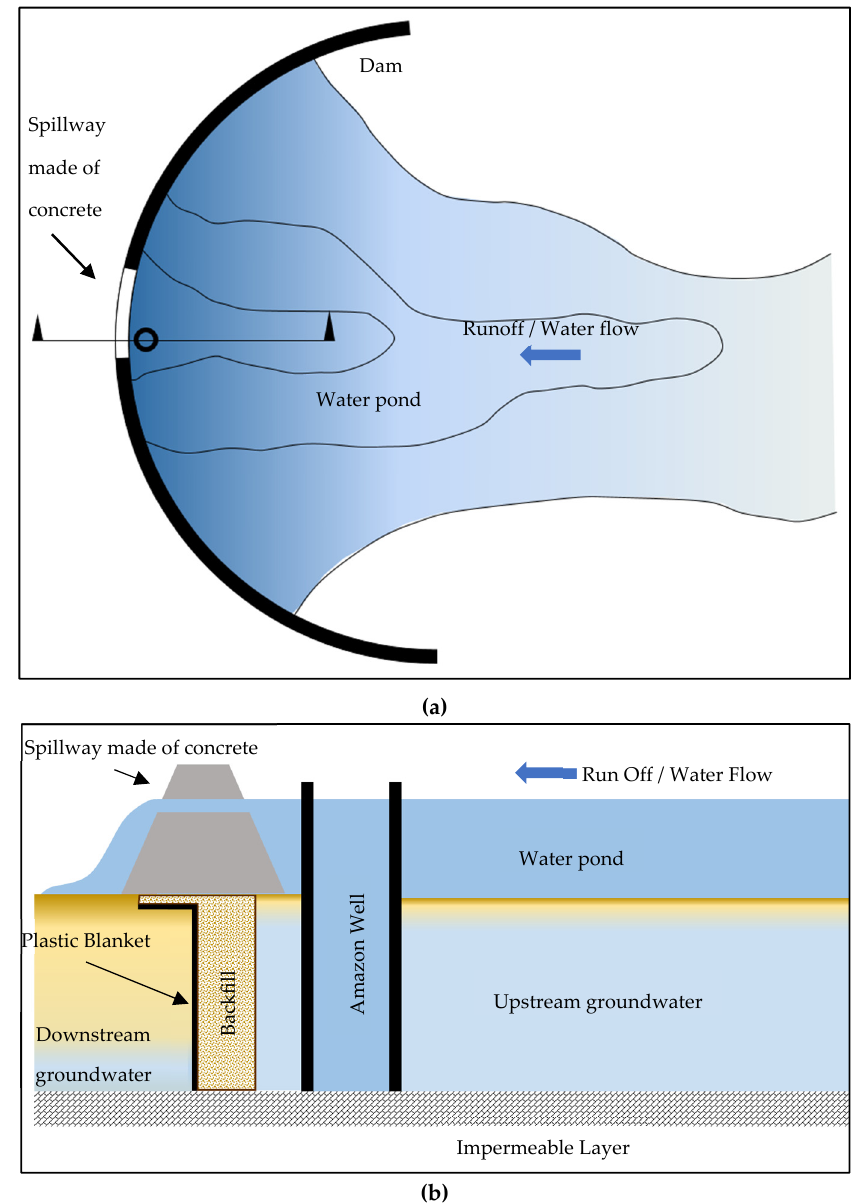
Figure 5. Submersible underground dam ( a ) ground plan; ( b ) cross section.